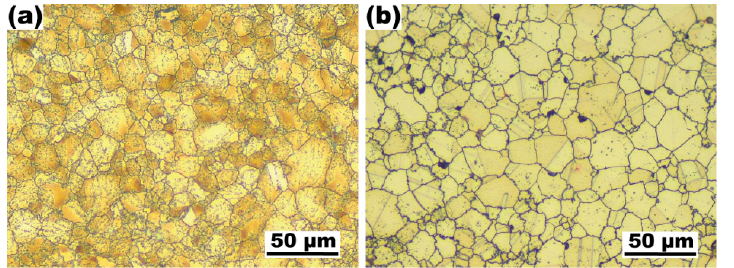
Figure 1. Representative OM images of as-extruded Cu-15Ni-8Sn-0.3Si-0.1Ti ( a ) and Cu-15Ni-8Sn ( b ) alloys.